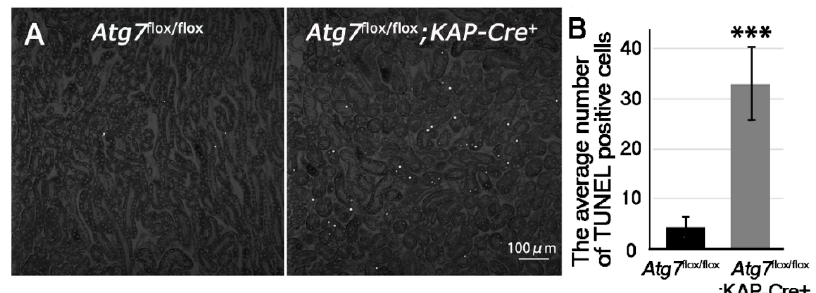
Figure 3. Increase of apoptosis in the cortico-medullary region of Atg7 flox/flox ;KAP-Cre + mouse kidney. ( A ) TUNEL staining in the cortico-medullary region of 2-month-old Atg7 flox/flox and Atg7 flox/flox ;KAP-Cre + kidney. Apoptosis in the cortico-medullary region of Atg7 flox/flox ;KAP-Cre + mouse kidney was detected using TUNEL staining. ( B ) Quantification of TUNEL positive cells of 2-month-old mice. TUNEL-positive signals were evaluated with ImageJ software ( Atg7 flox/flox n = 4 and Atg7 flox/flox ;KAP-Cre + n = 5 *** p < 0.01). Statistical analyses were performed using a student’s t-test. Data in the graph are expressed as the mean ± SEM.